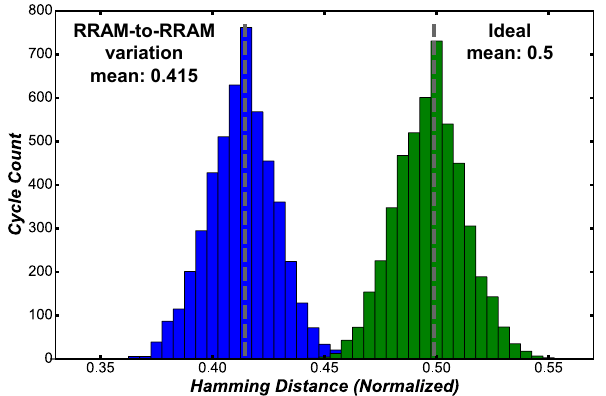
Figure 18: The simulated inter-configuration hamming distance with and without RRAM- to-RRAM variability. The HD config is shifted lower as more devices are likely to produce the same result after